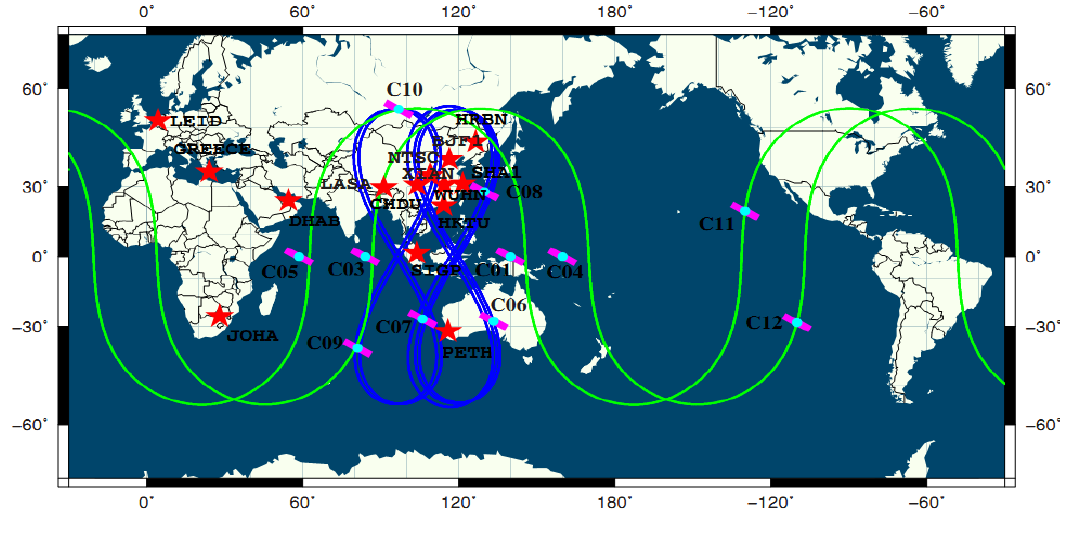
Figure 1. The distribution of “BETS” and the tracks of the sub-satellite points of four GEO, five IGSO and two MEO BeiDou Satellites.